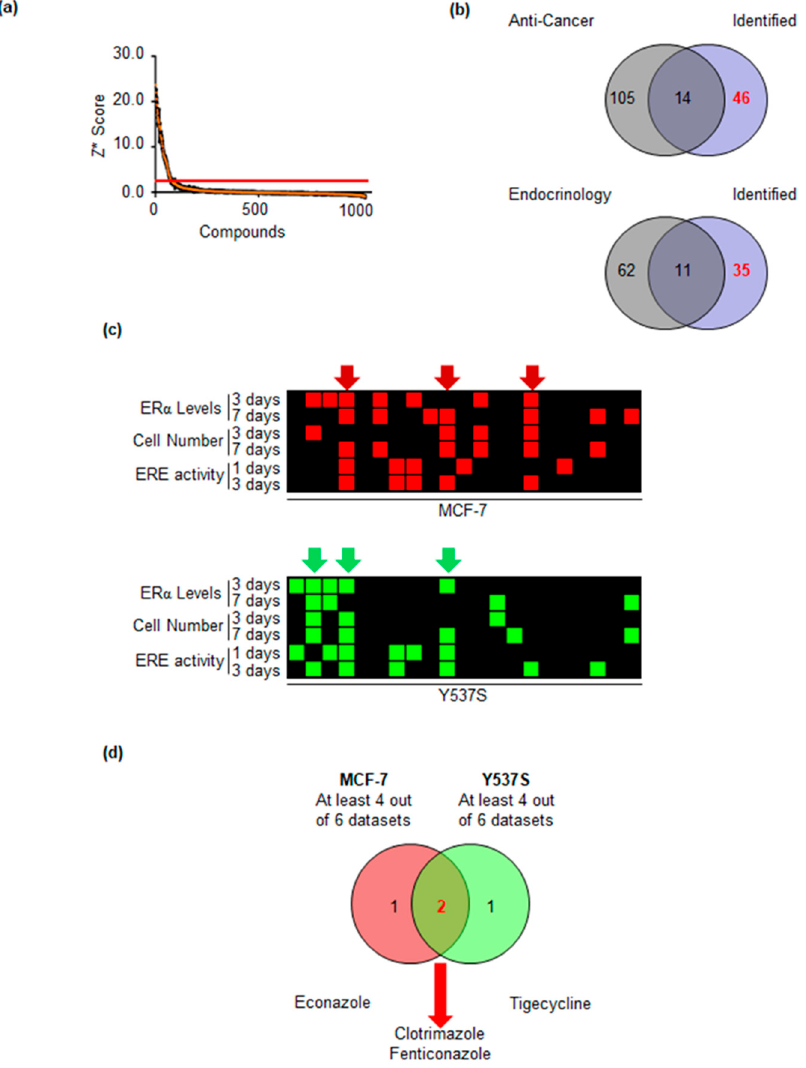
Figure 1. Identification of FDA-approved drugs binding to the ER α . ( a ) Z* for each of the 1018 com- pounds in the FDA-approved drug library toward in vitro ER α competitive binding assays ( b ) Venn diagrams depicting the procedure to filter out from the initial list the anti-cancer and endocrinological drugs. ( c ) Heatmap depicting the positive hits of the 21 selected drugs towards their ability to modulate ER α levels, transcriptional activity, and cell proliferation in both MCF-7 (upper panel) and Y537S (lower panel) cells. ( d ) Venn diagram depicting the identified drugs.